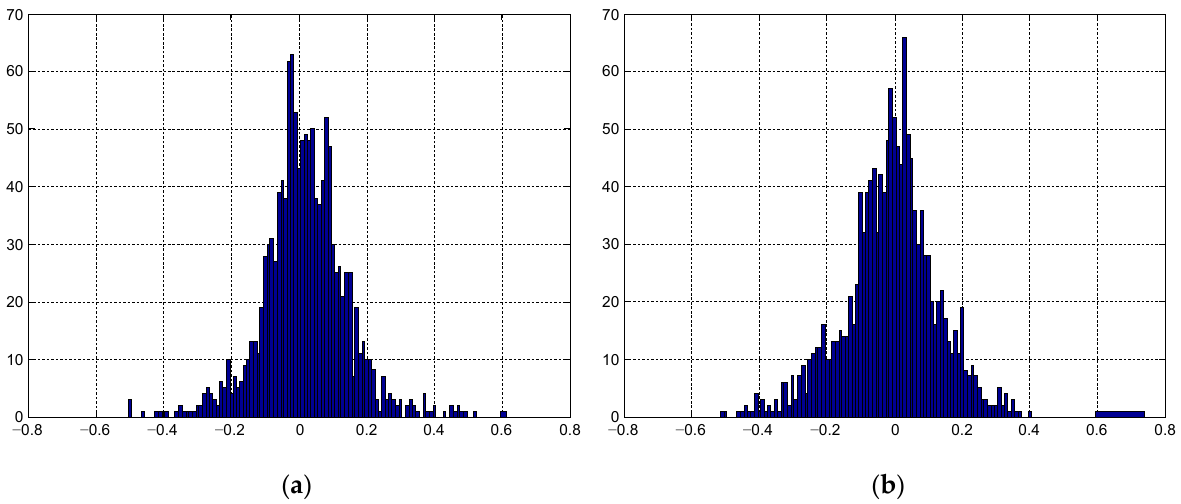
Figure 16. The distribution of relative elevation difference between tie-points in each strip, where ( a ) is N510 and ( b ) is N511. The abscissa in the figure is relative elevation difference (in meters) between tie-points, and the ordinate is the number of tie-points corresponding to relative elevation